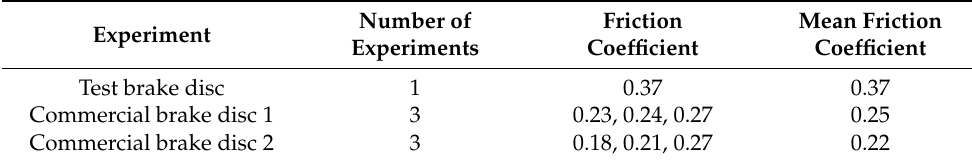
Table 6. Friction coefficients of the three brake discs in static torque